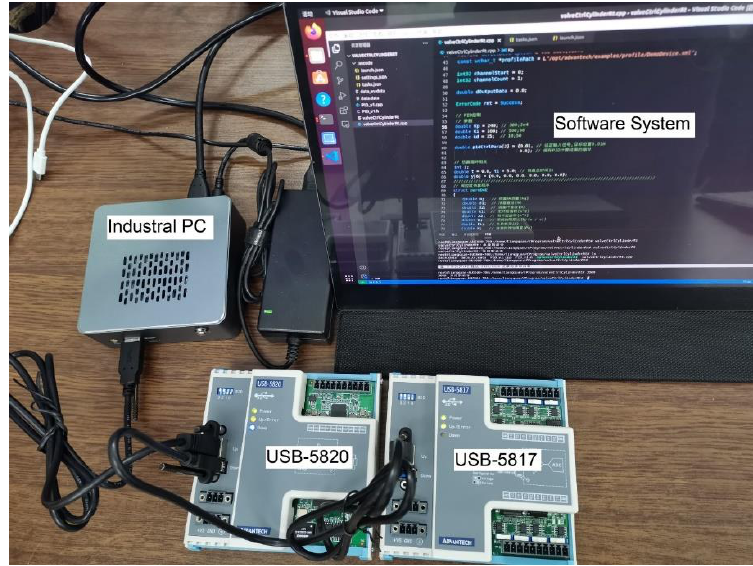
Figure 9. Physical HIL simulation system prototype.